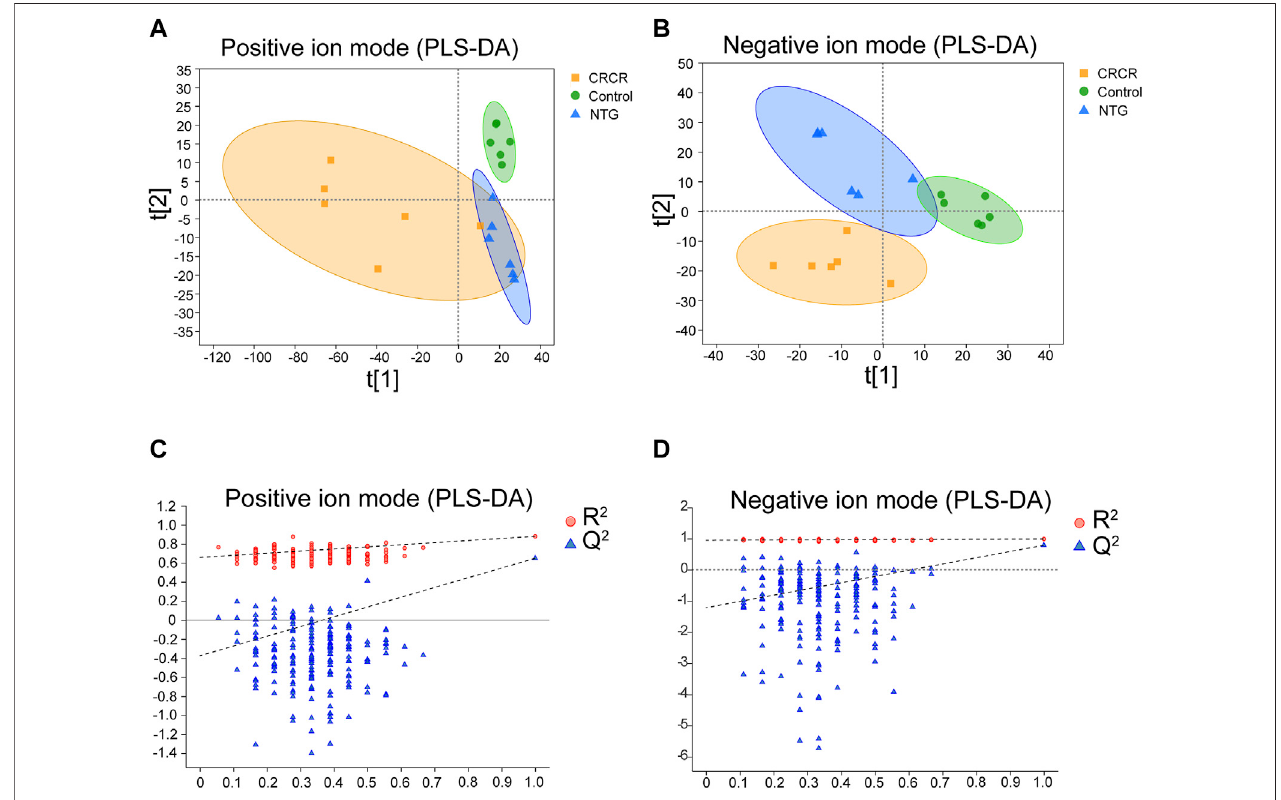
FIGURE 3 | Partial least squares discriminate analysis (PLS-DA) score plots and the corresponding permutation test plots based on the UHPLC-Q-extractive MS data of control, nitroglycerin injection (NTG), and Conioselinum anthriscoides “ Chuanxiong ” (Apiaceae; Chuanxiong rhizoma) and Cyperus rotundus L. (Cyperaceae; Cyperi rhizoma) (CRCR) groups in the positive (A,C) and negative ion modes (B,D) .